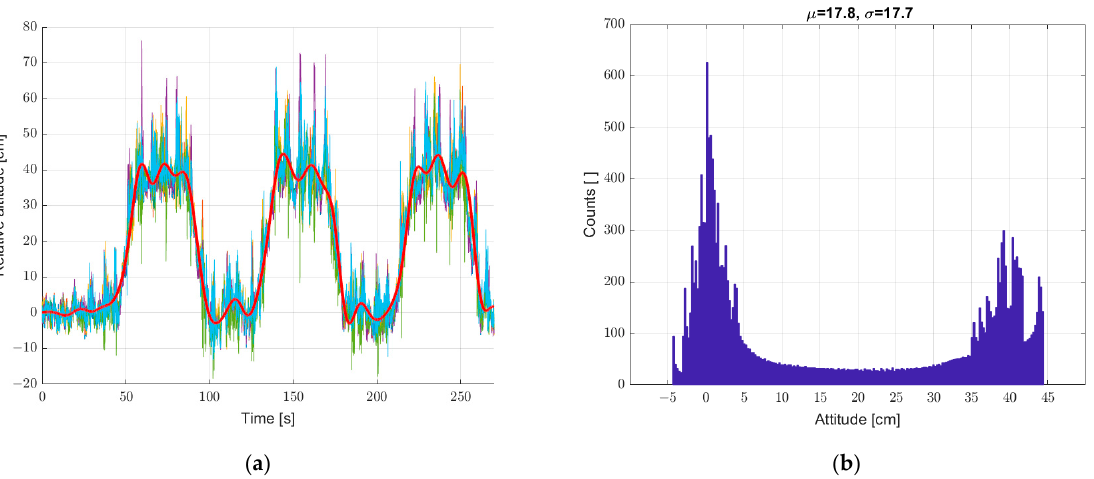
Figure 18. ( a ) Graph over time with 6 + 1 bold plot calculated from data averaged and filtered with IIR low-pass filter, and ( b ) histogram. Dynamic measurements—sensor array in motion, with additional variable crosswind gusts.